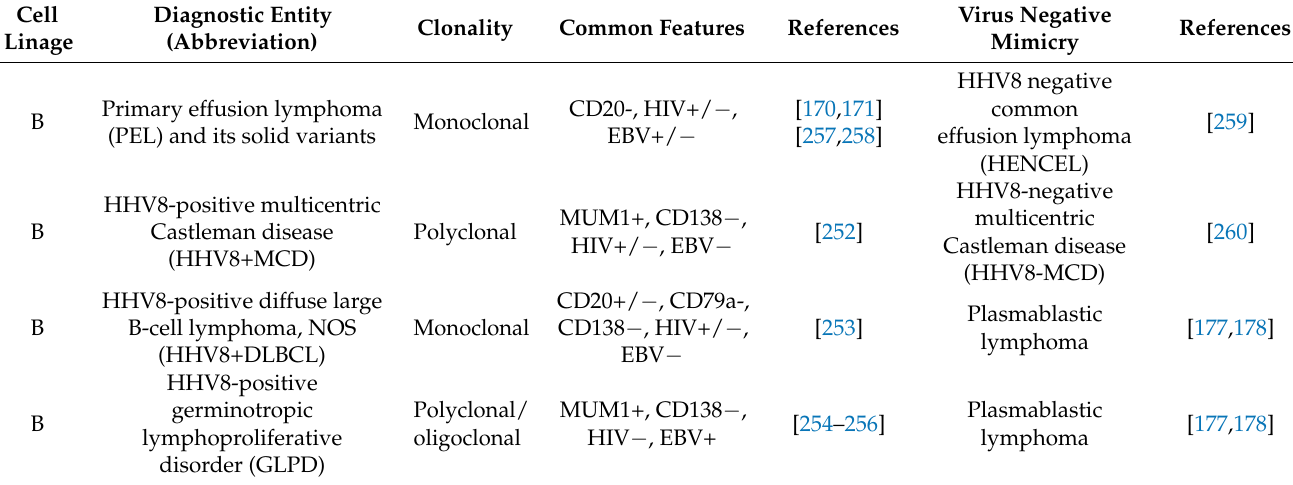
Table 5. Association between hematolymphoid lesions and